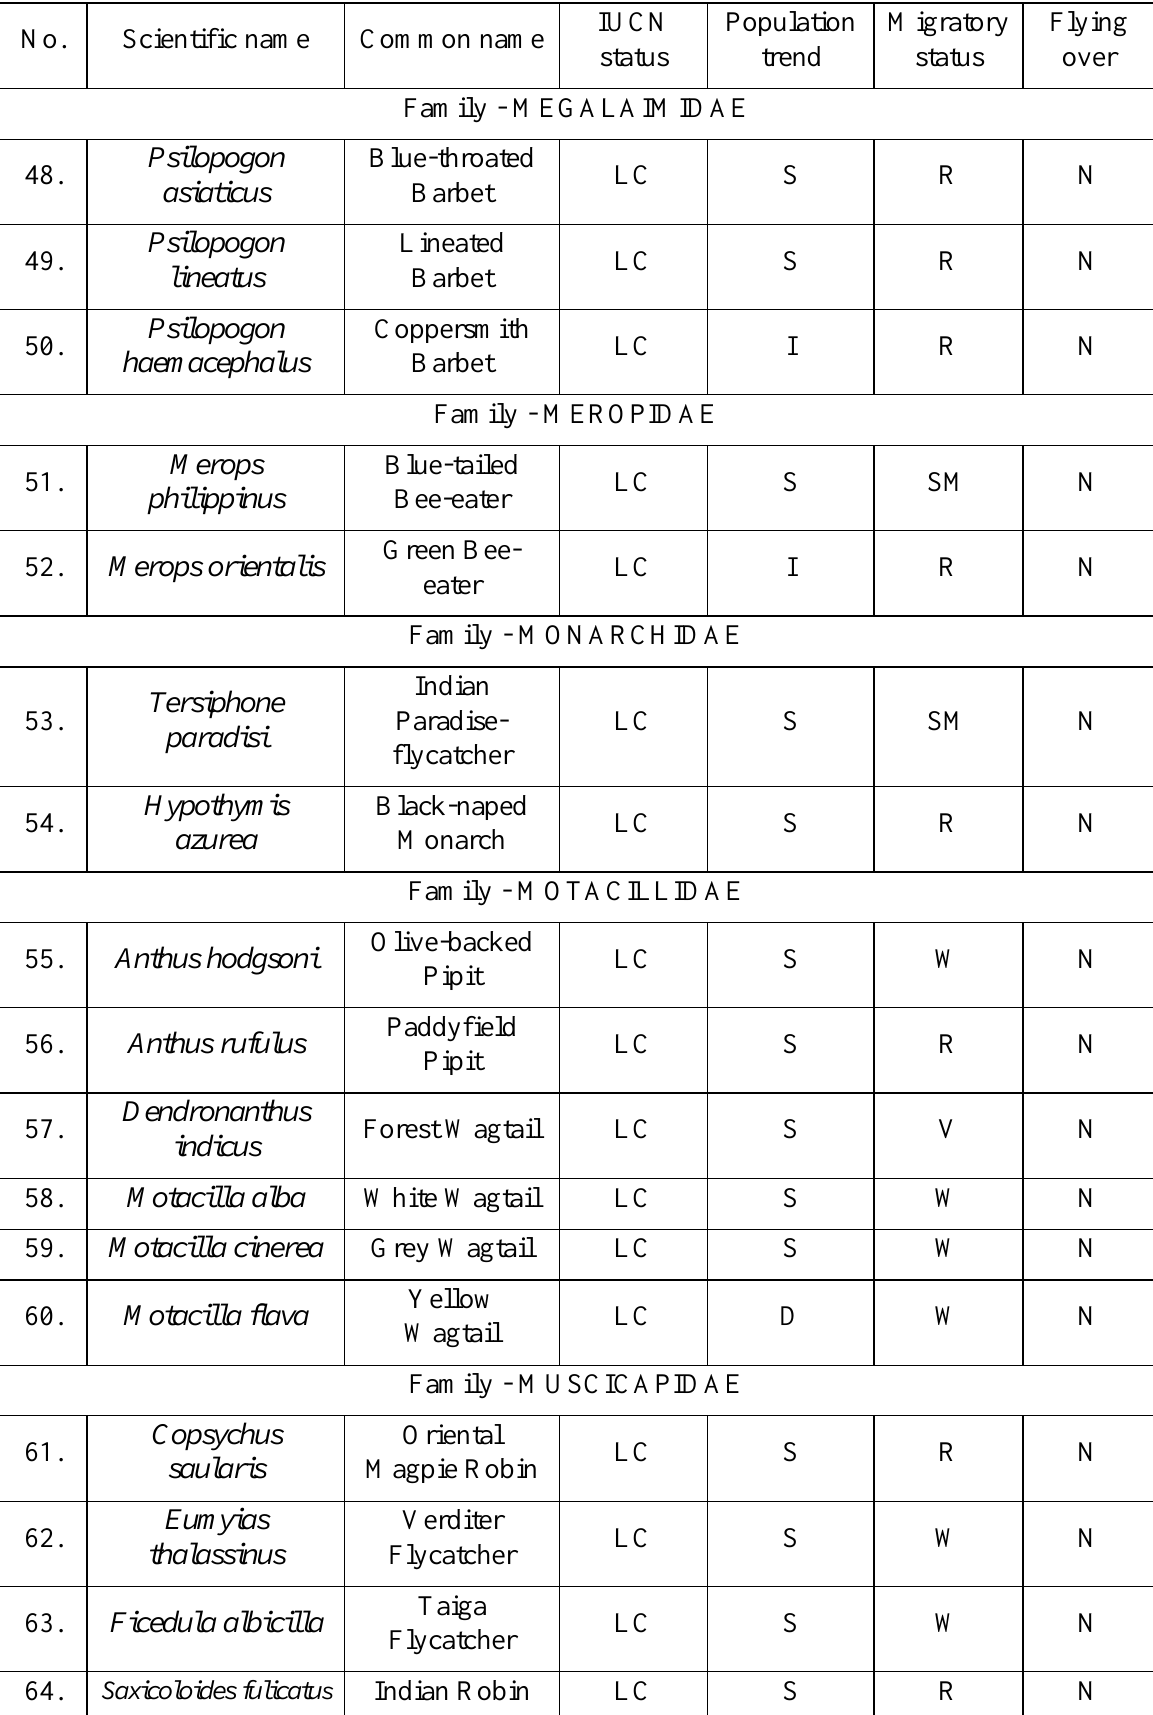
Table 1. List of bird species recorded in Durgapur Government College Campus (continued)